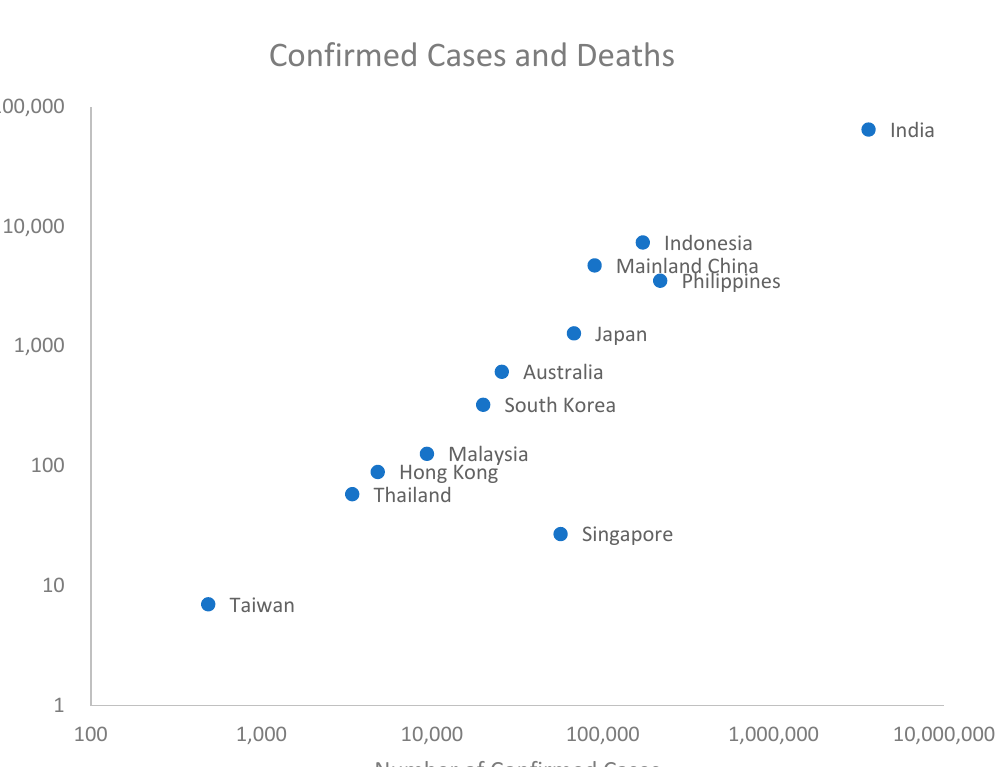
Figure 1. Total Confirmed Cases and Deaths due to COVID-19 as of the End of August 2020 in the Asia–Pacific region. Source: Our World in Data.